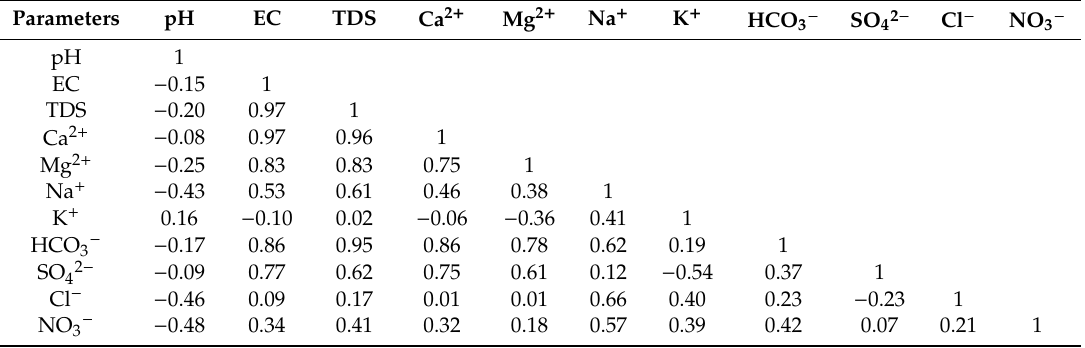
Table 4. Correlation matrix between various parameters in the Lhasa